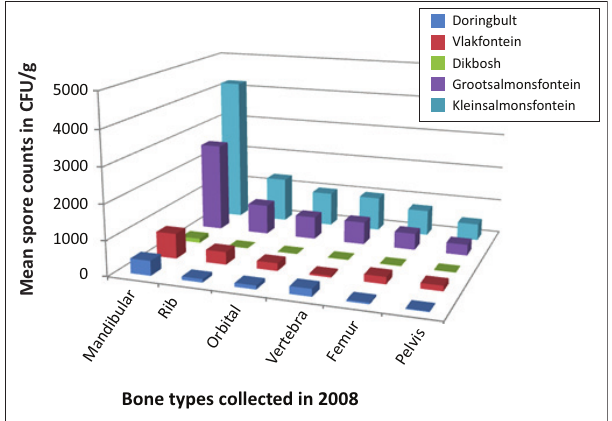
FIGURE 2-A1: The mean Bacillus anthracis spore counts (in colony forming units per gram) obtained from different bones types in the same carcass on farms afflicted with anthrax in 2008, Northern Cape, South Africa.